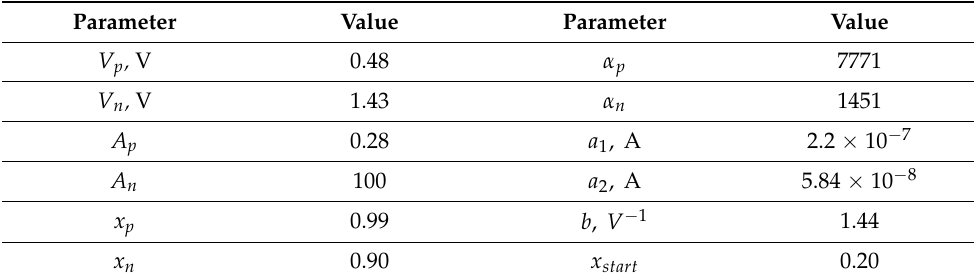
Table 6. Optimal values of the Yakopcic’s model obtained by approximation of the experimental loop.